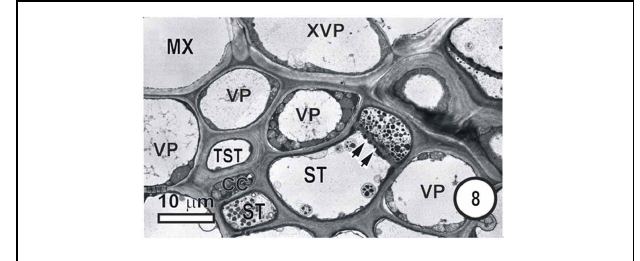
FIGURE 8 | Aspects of anatomy and cell associations in a small intermediate vein in Eragrostis plana . Part of two metaxylem vessels (MX, extreme left top and right top) are separated from the phloem by XVP. This vein contains a single TST and several ST. Lateral sieve area pores (paired arrowheads) connect the two central STs.